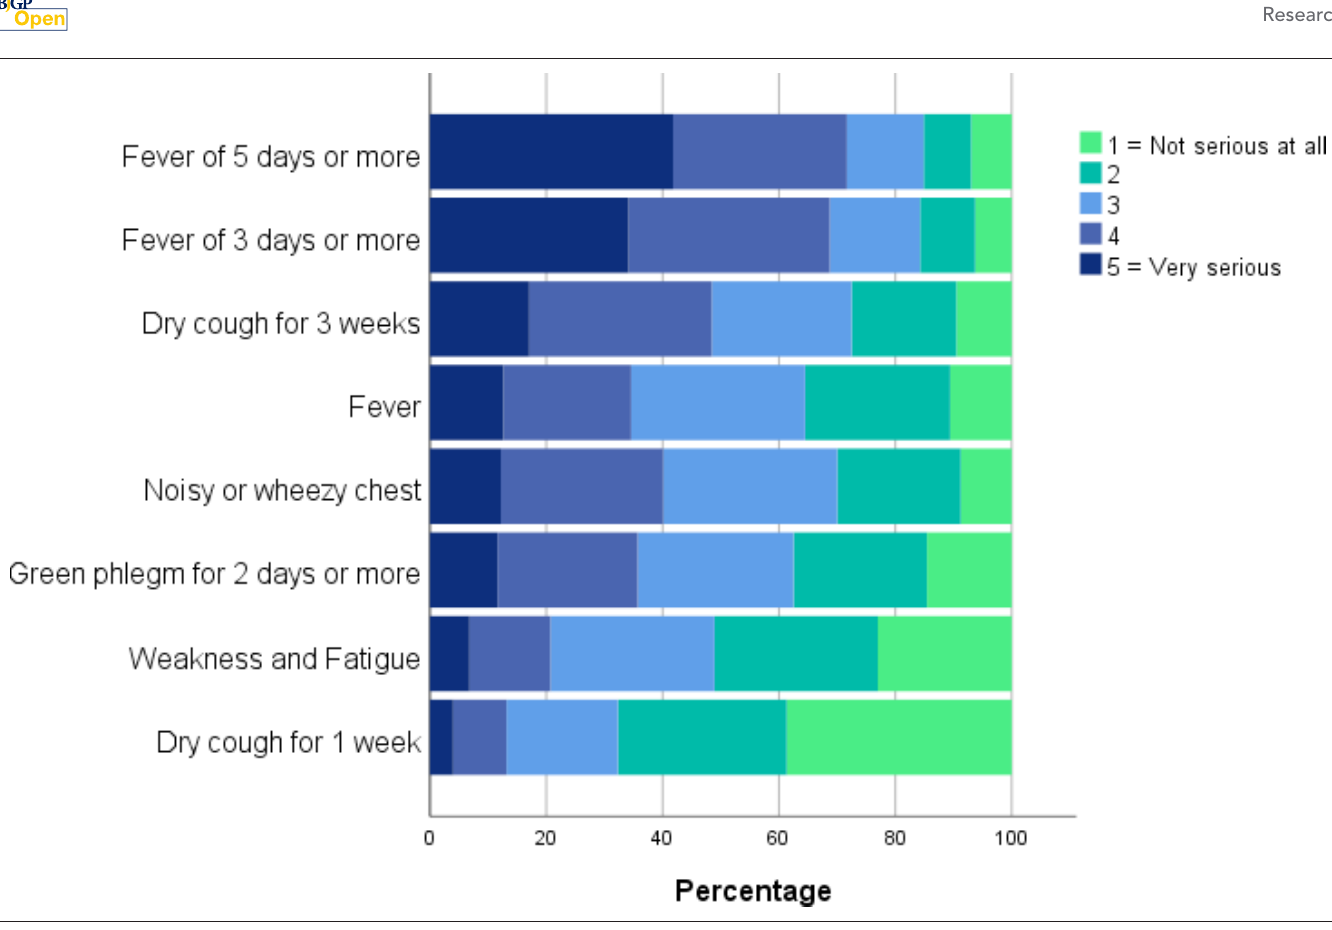
Figure 2 Public perceptions of seriousness of features associated with respiratory tract